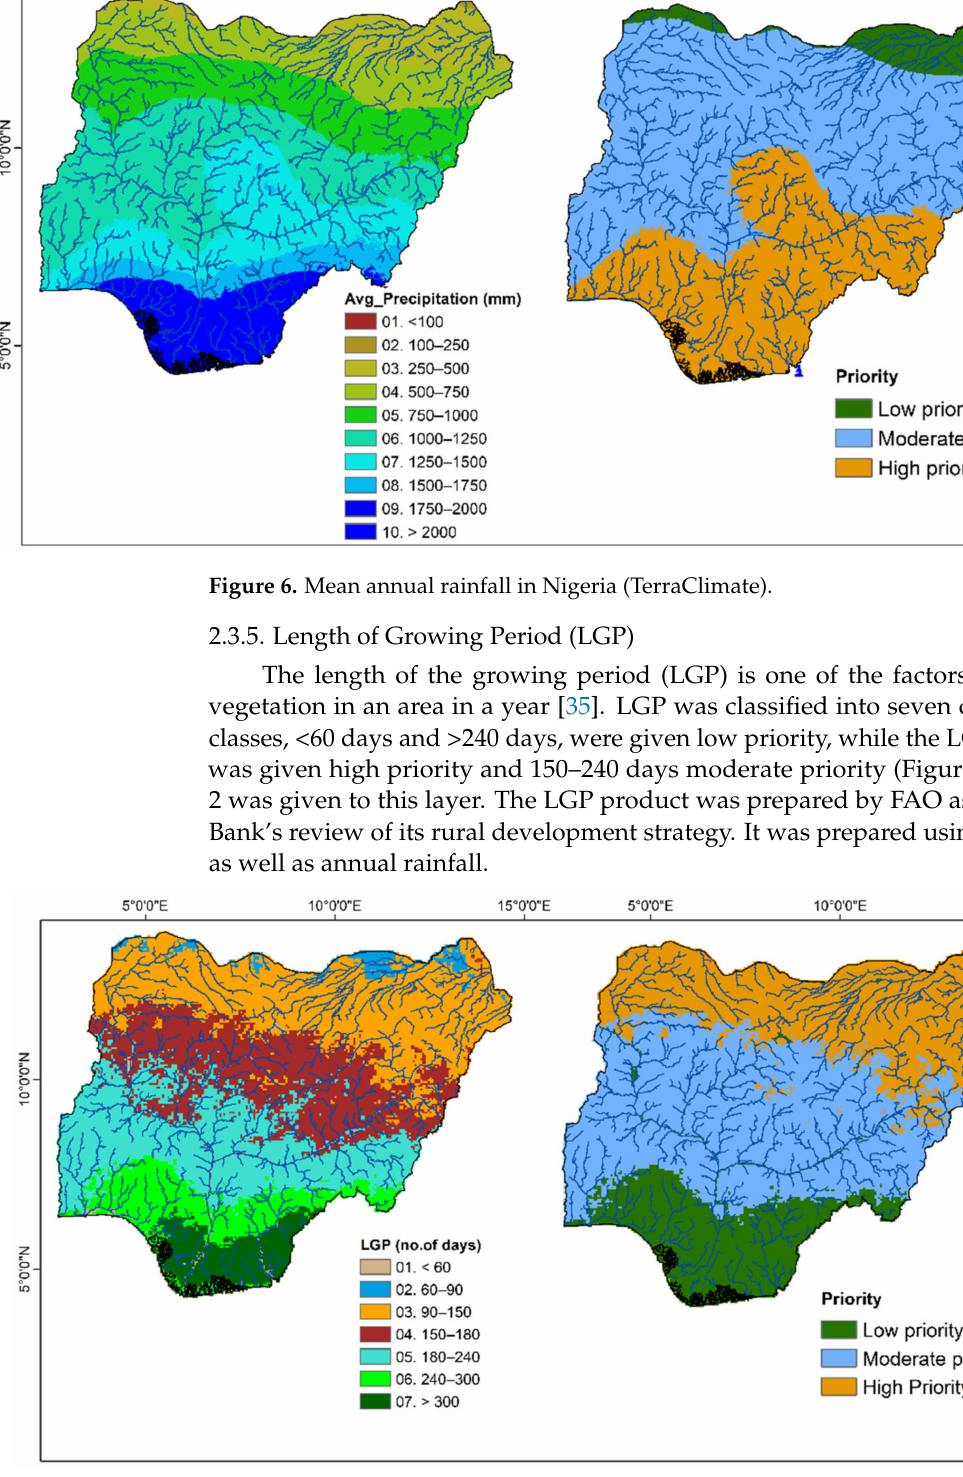
Figure 7. Length of the growing period (LGP) in